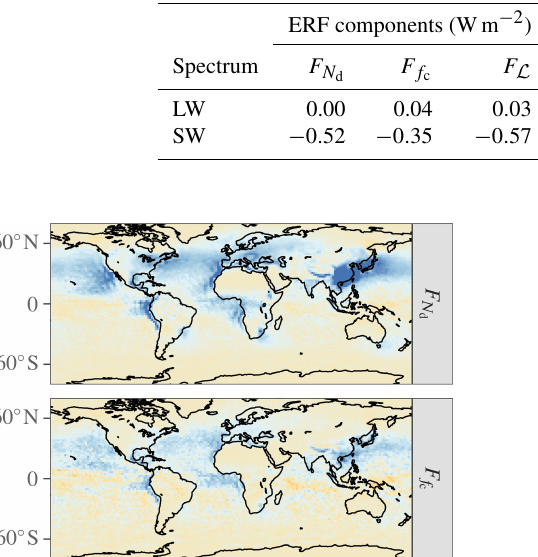
Table 1. ERF aci components in ECHAM–HAMMOZ estimated by forward–backward PRP. The total ERF also includes the ice-phase ACI